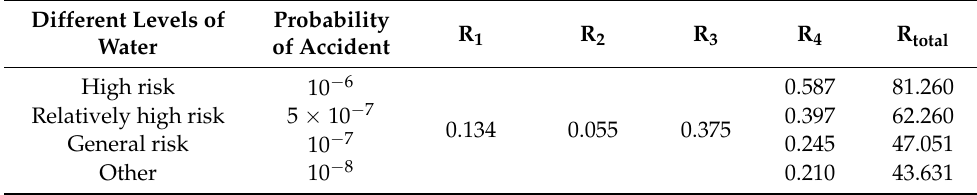
Table 15. Transportability risk values for fireworks carried on Ship